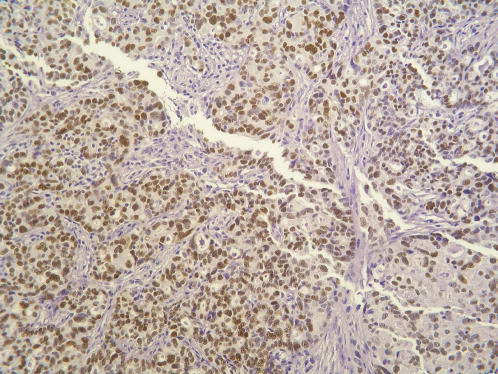
p53 immunohistochemical staining of a serous papillary adenocarcinoma (sample CA99) displaying strong diffuse p53 immunoreactivity.Intense staining of tumor cells is typically associated with the presence of point mutational damage in p53 exons 5–8 (magnification X 400).